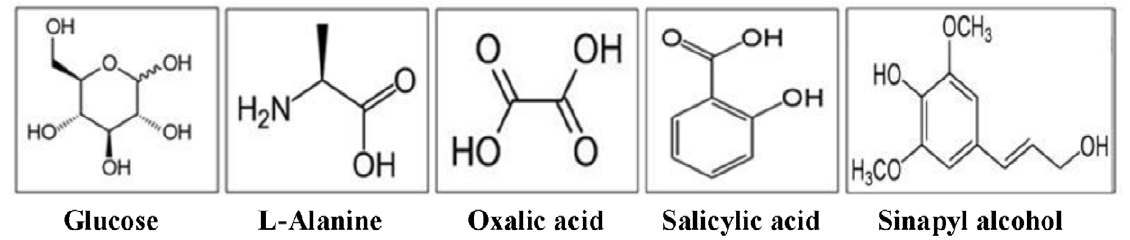
Figure 1. Chemical structures of selected organic compounds.